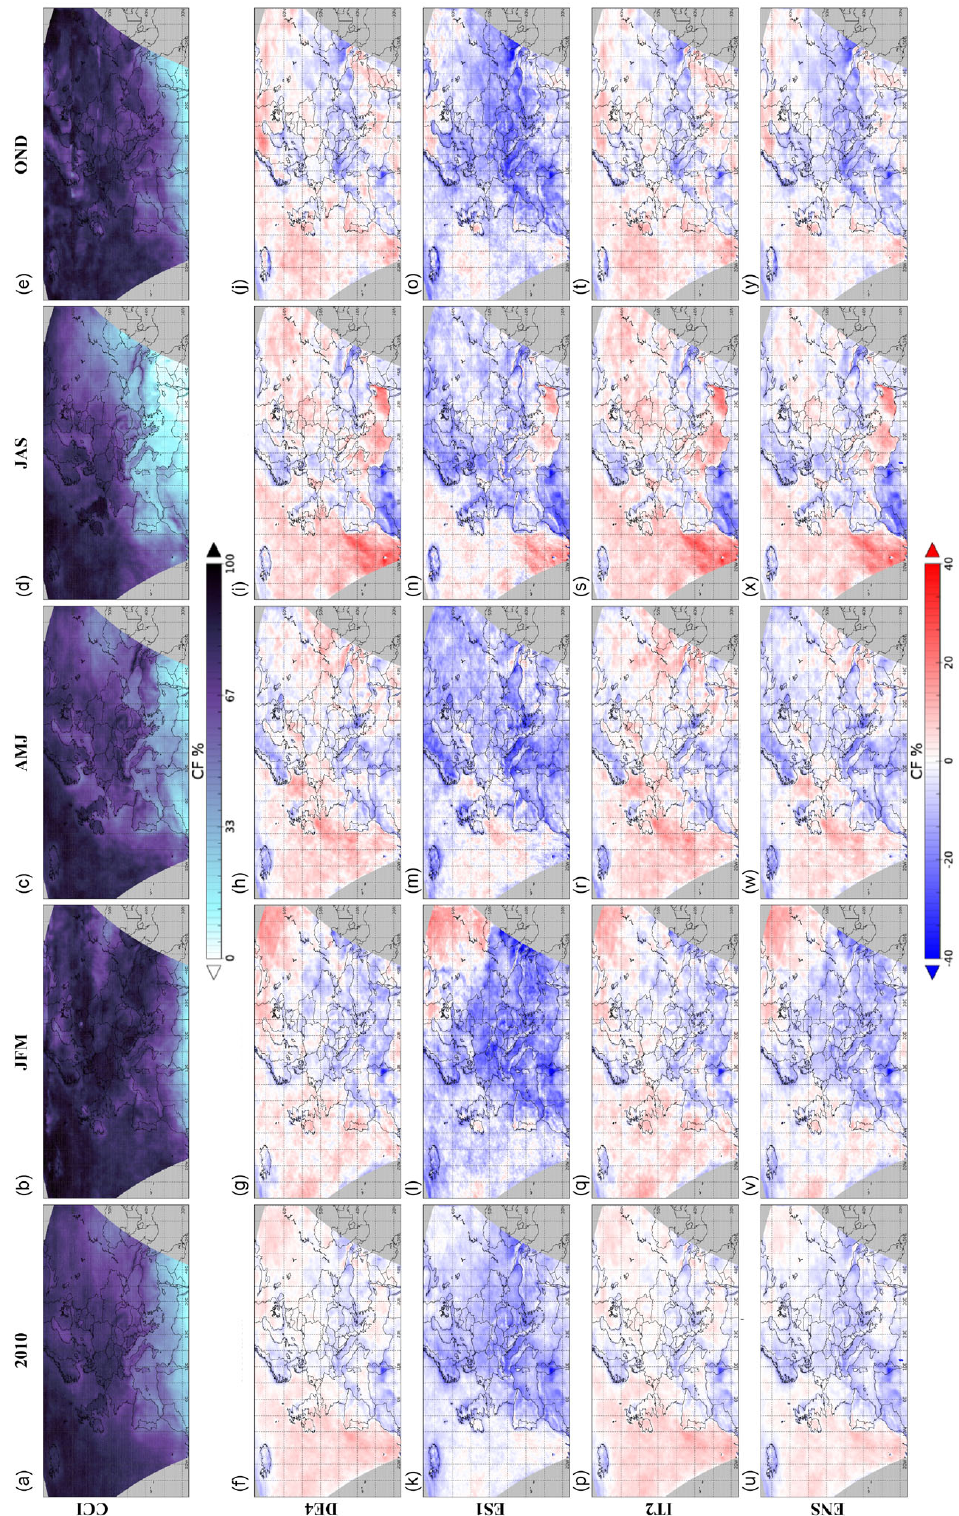
Figure 1. Mean bias error (bias) CF. First row represents the mean satellite values of 2010 (first column), JFM (second column), AMJ (third column), JAS (fourth column), OND (fifth column). Following rows represent the bias of the models: DE4 – second row; ES1 – third row; IT2 – fourth row; NL2 – fifth row; UK4 – sixth row; ENS – seventh